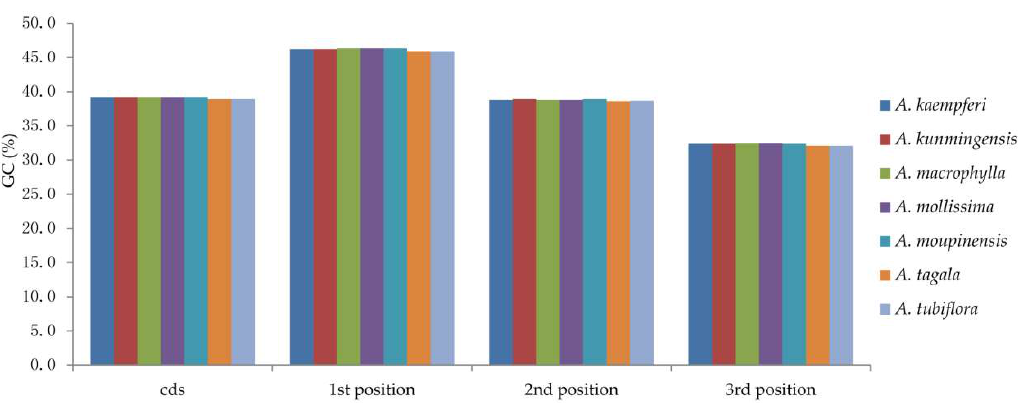
Figure 2. The GC (%) composition in different positions of coding sequence (CDS) region of species within Aristolochia .